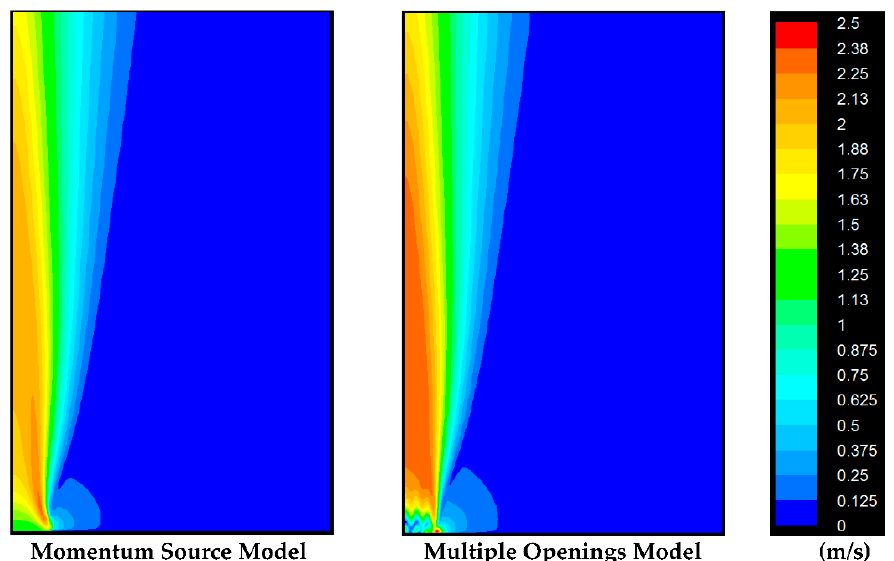
Figure 8. Velocity fields predicted by momentum source model and multiple openings model along vertical plane cutting through the symmetry plane of the tile.